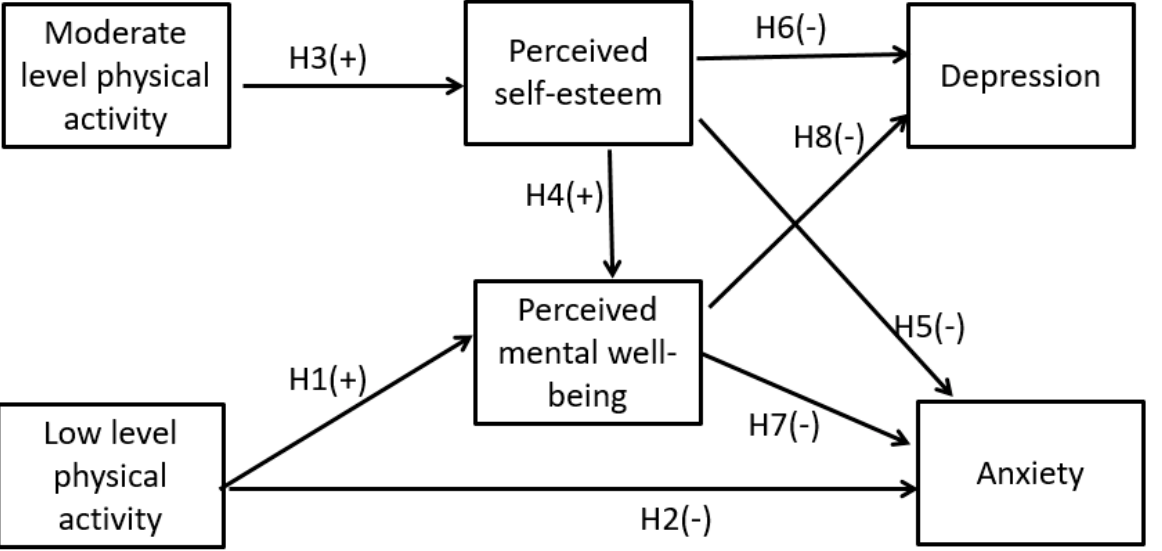
Figure 2. Research model (source: authors). Note: H indicates hypothesis; + sign indicates positive association; and - sign indicates negative association.